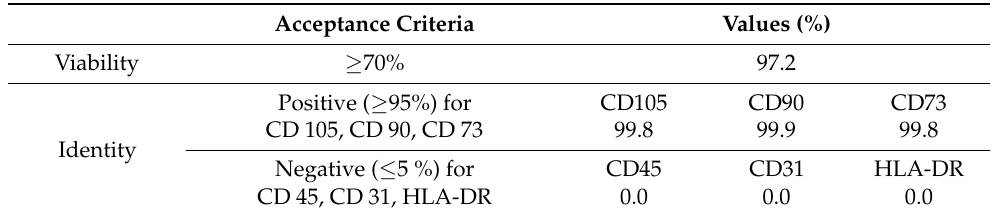
Table 2. Immunophenotype of human MSC,WJ used in this study was in accordance with specifica- tions established in the approved IMPD.